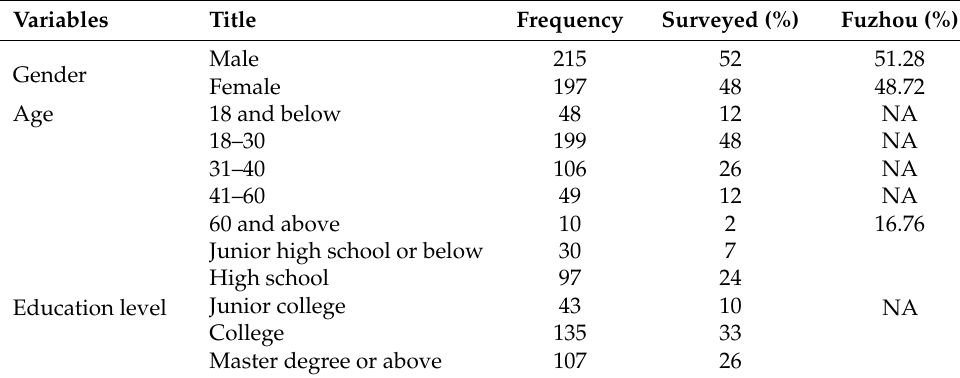
Table 1. Demographic information of study sample.